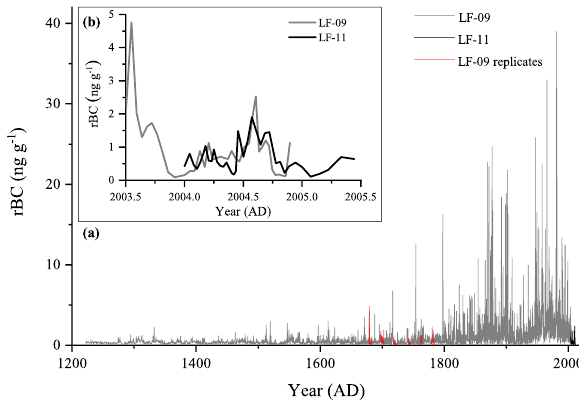
Figure 2. rBC raw data from the LF-09 and LF-11 cores, (a) com- bined for the entire records, spanning 1222–2011 and including the replicate measurements and (b) showing the overlap between the two ice cores for the year